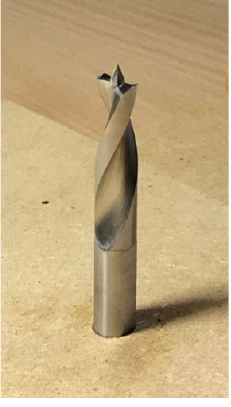
Figure 1. Leitz HSS drill bit.